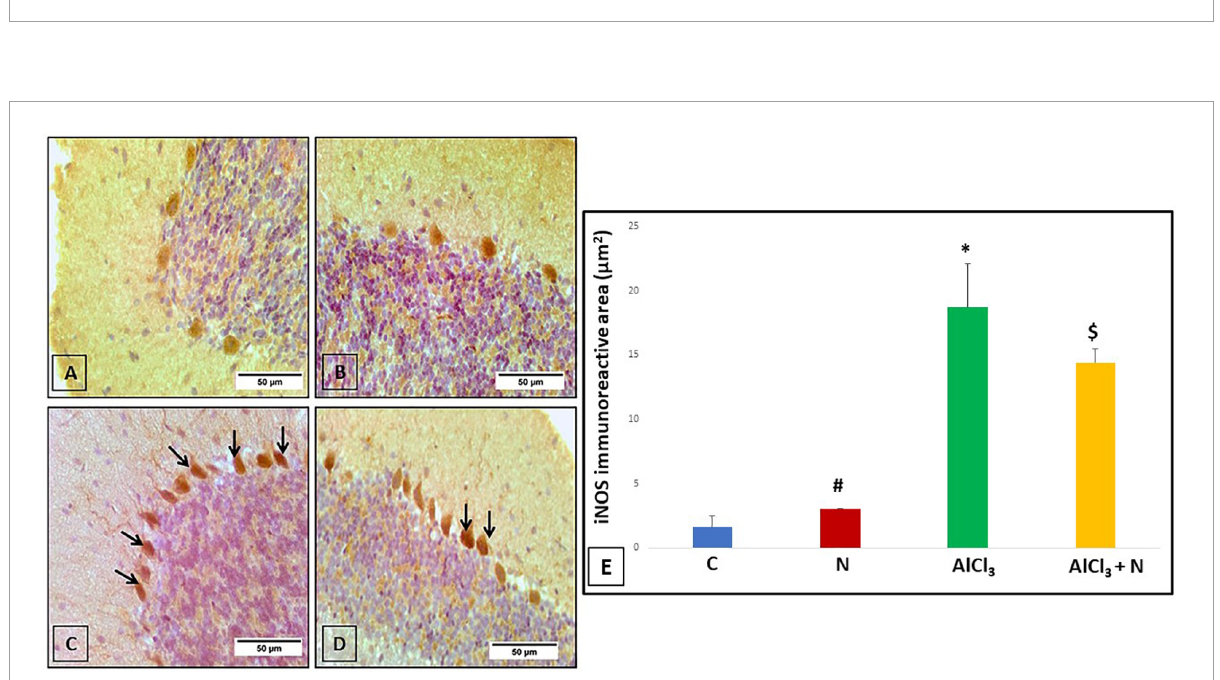
FIGURE8 Immunohistochemical detection of cerebellar iNOS (A,B) C and N groups, respectively showed negative iNOS immunostaining. (C) AlCl 3 group showed strong positive iNOS immunostaining in most Purkinje cells (arrows). (D) AlCl 3 + N group showed weak positive immunostaining for iNOS in some Purkinje cells (arrows) (iNOS × 400). (E) Area% of iNOS positive immune reaction in cerebellar sections of all studied groups. n = 6 in each group. Data were prescribed as mean ± SD . The intergroup variation was conducted by Games-Howell post-hoc test. ∗ p < 0.001 compared with C group. # p < 0.001 compared with AlCl 3 . $ p < 0.001 compared with AlCl 3